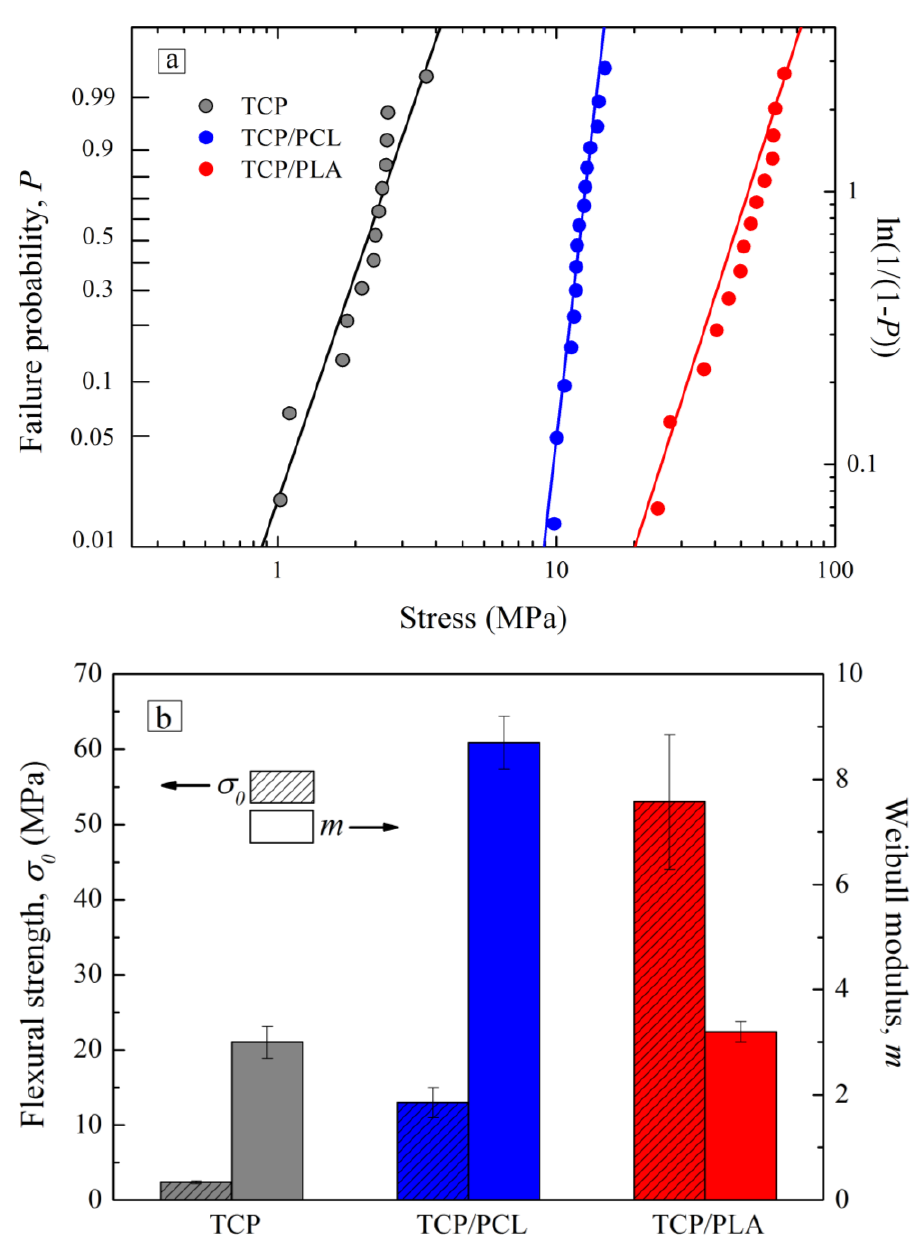
Figure 6. ( a ) Weibull bending strength plots for TCP, TCP/PCL, and TCP/PLA